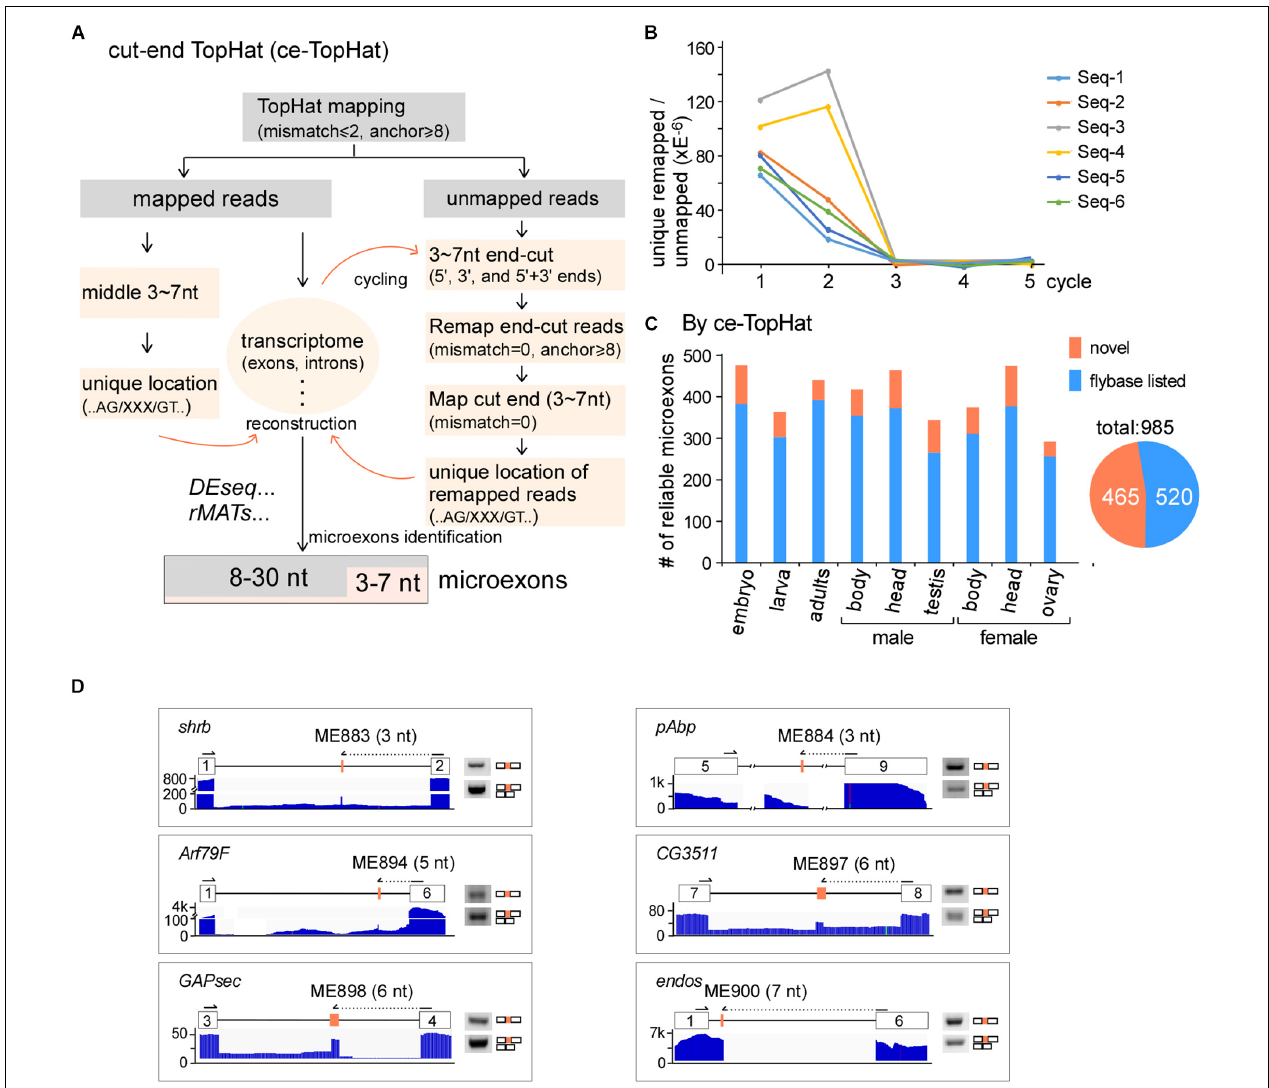
FIGURE 2 | Identification of microexons in Drosophila by ce-TopHat. (A) Strategy for the identification of microexons by ce-TopHat. (B) Unique genomic locations of the remapped reads reach zero after three cycles of ce-TopHat. Six RNA-seq samples are indicated here, and other tested samples are shown in Supplementary Figure 2 . (C) Identified reliable microexons from a variety of Drosophila samples using ce-TopHat. Orange: novel microexons; blue: annotated microexons on Flybase. (D) Validation of 3–7 nt novel microexons by RT-PCR. Arrows indicate the location of one set of PCR primers. All the PCR products were confirmed by Sanger